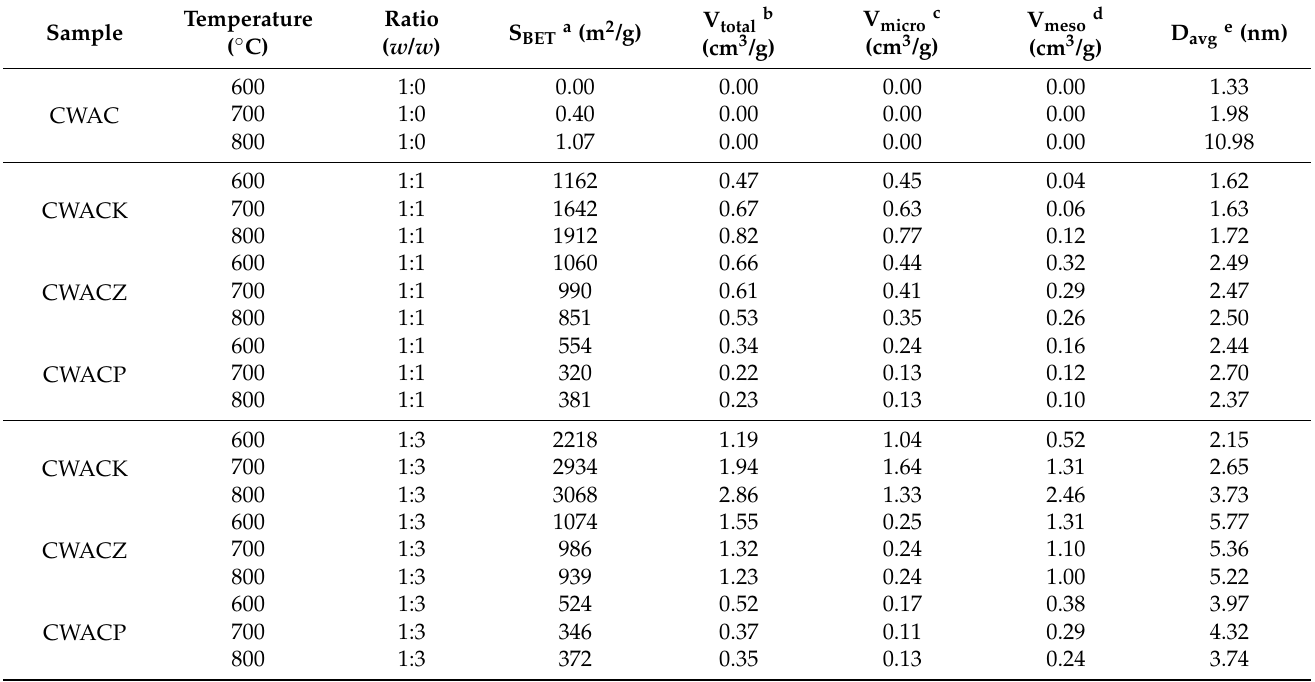
Table 5. BET surface area of coffee waste activated carbon prepared at various